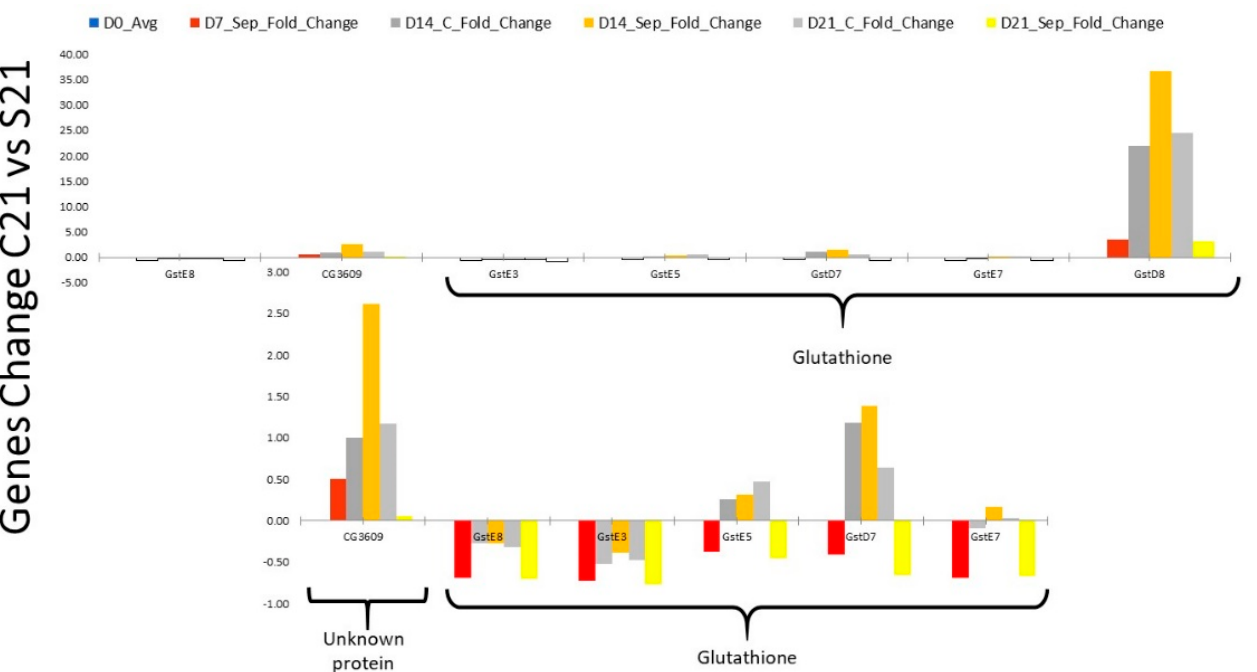
Figure 3. Abnormal expression of glutathione gene among Drosophila surviving sepsis is the dominant trait seen in our study.